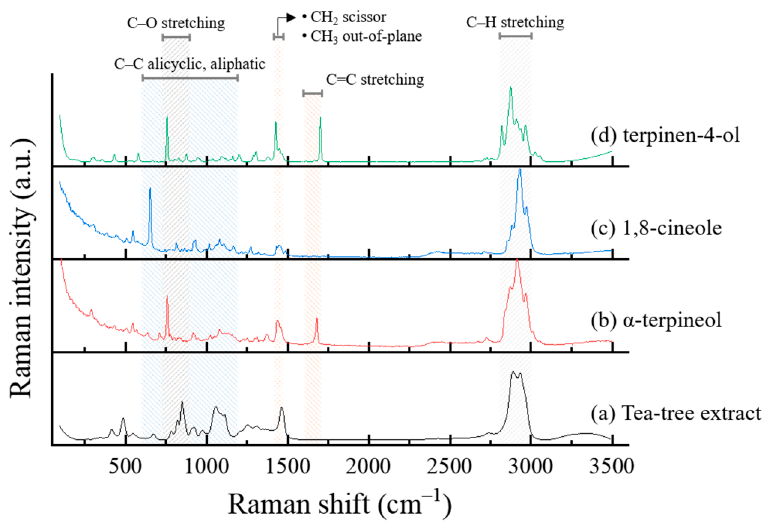
Figure 8. Raman spectra of ( a ) tea tree extract, ( b ) α -terpineol, ( c ) 1,8-cineole, and ( d ) terpinen-4-ol.